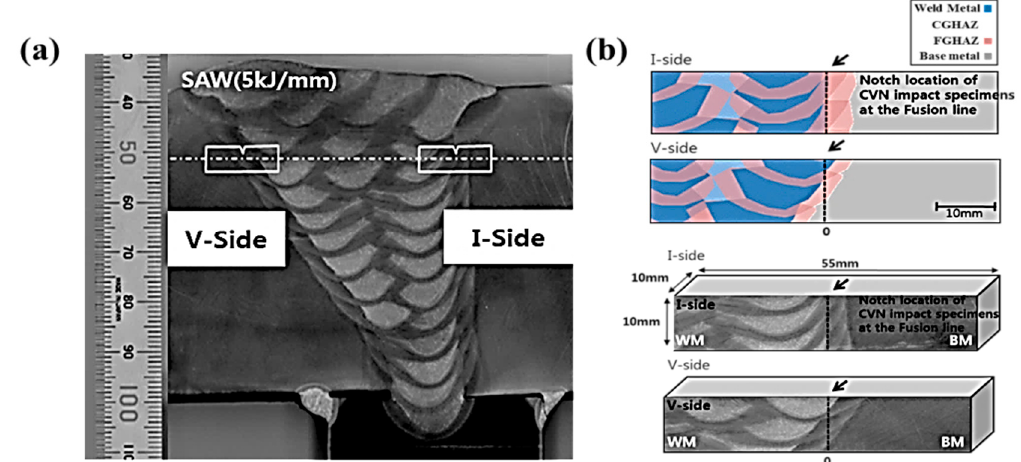
Figure 10. Macrostructure and notch location of the real welded joint: ( a ) macrostructure of a real welded joint; ( b ) notch location of the CVN impact specimen at the fusion line according to the groove shape (I- and V-sides).